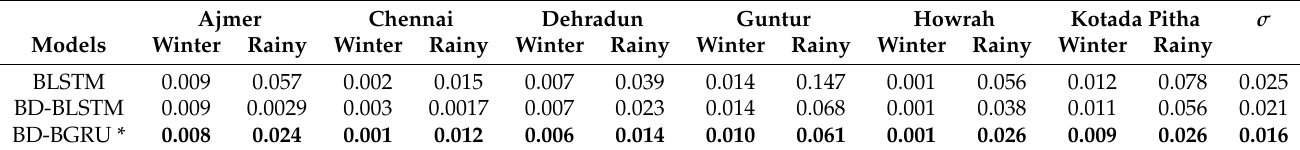
Table 8. Forecasting performance of BLSTM, BD-BLSTM, and BD-BGRU measured on nRMSE. Ajmer Table 8. The forecasting performance of BLSTM, BD-BLSTM, and BD-BGRU measured on nRMSE.